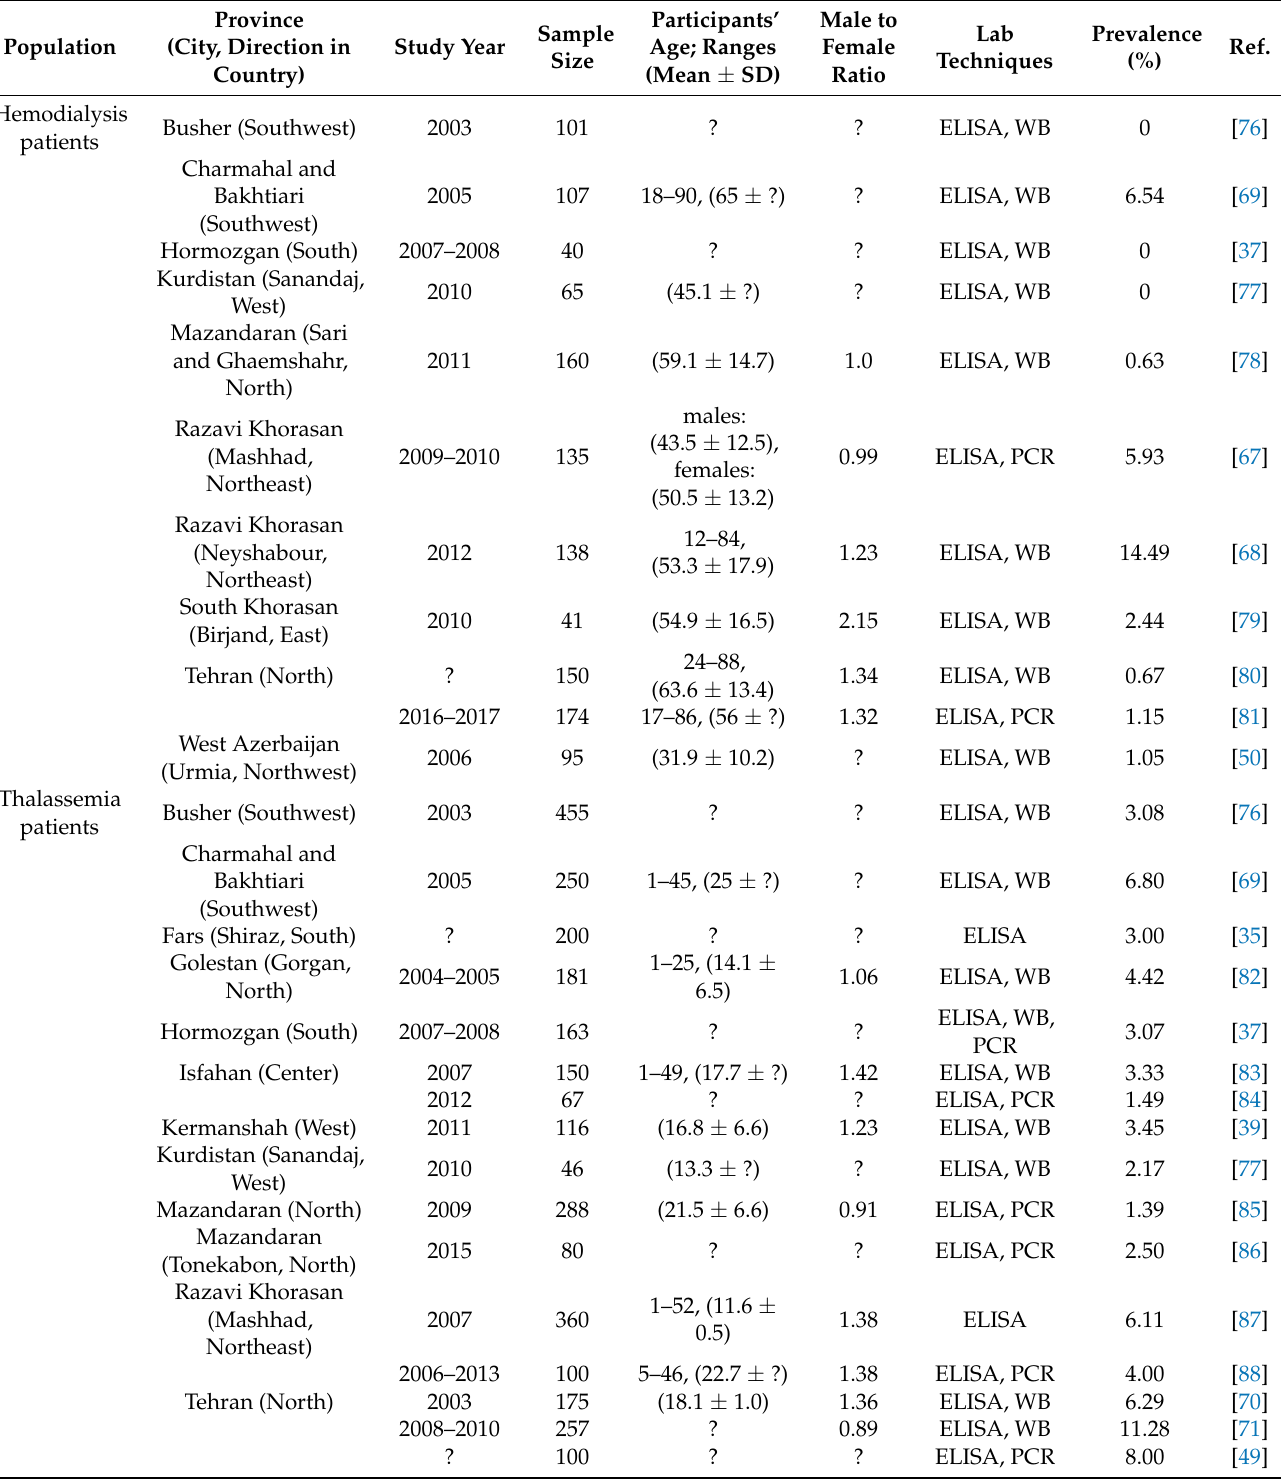
Table 2. Prevalence of HTLV-1 infection among high-risk populations of Iran;